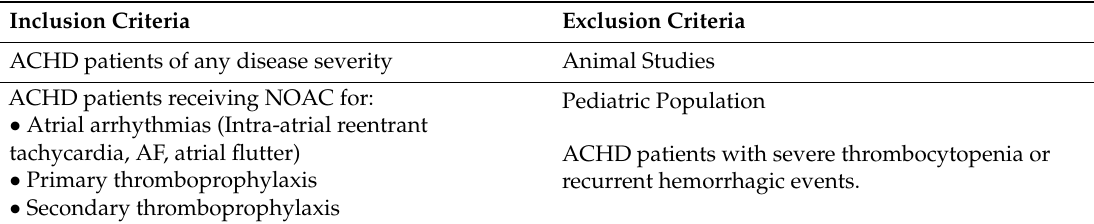
Table 1. Eligibility